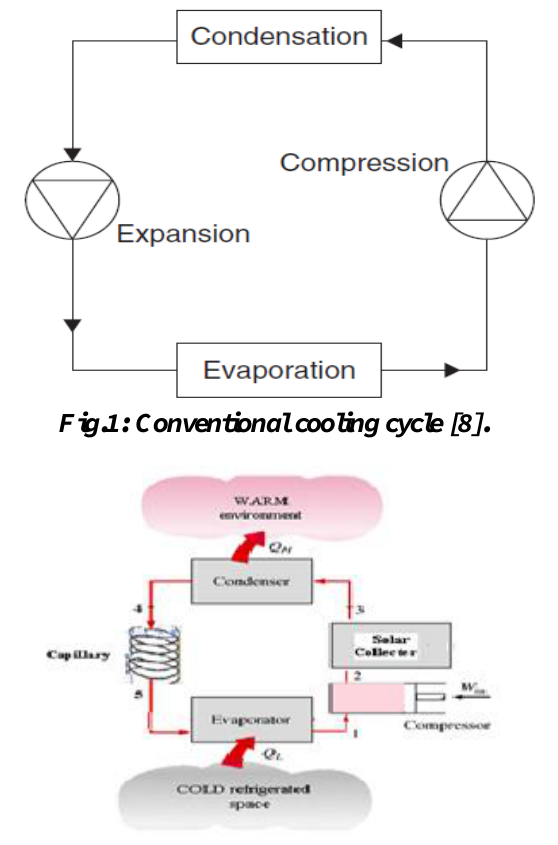
Fig. 2: Hybrid cooling cycle [9]